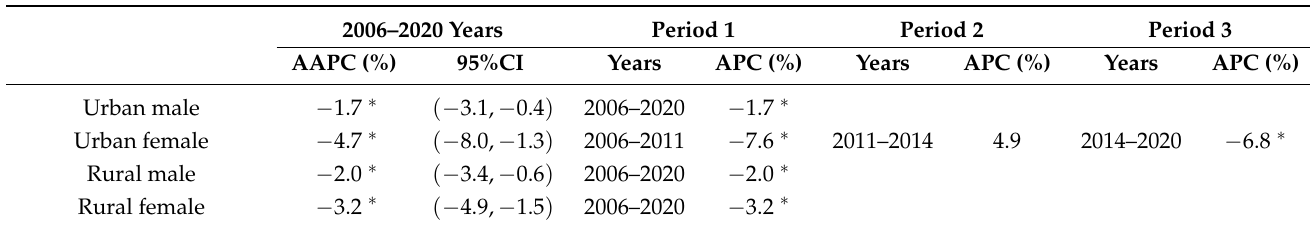
Table 2. AAPC and APC of the crude mortality rate of RHD among urban and rural men and women in China.